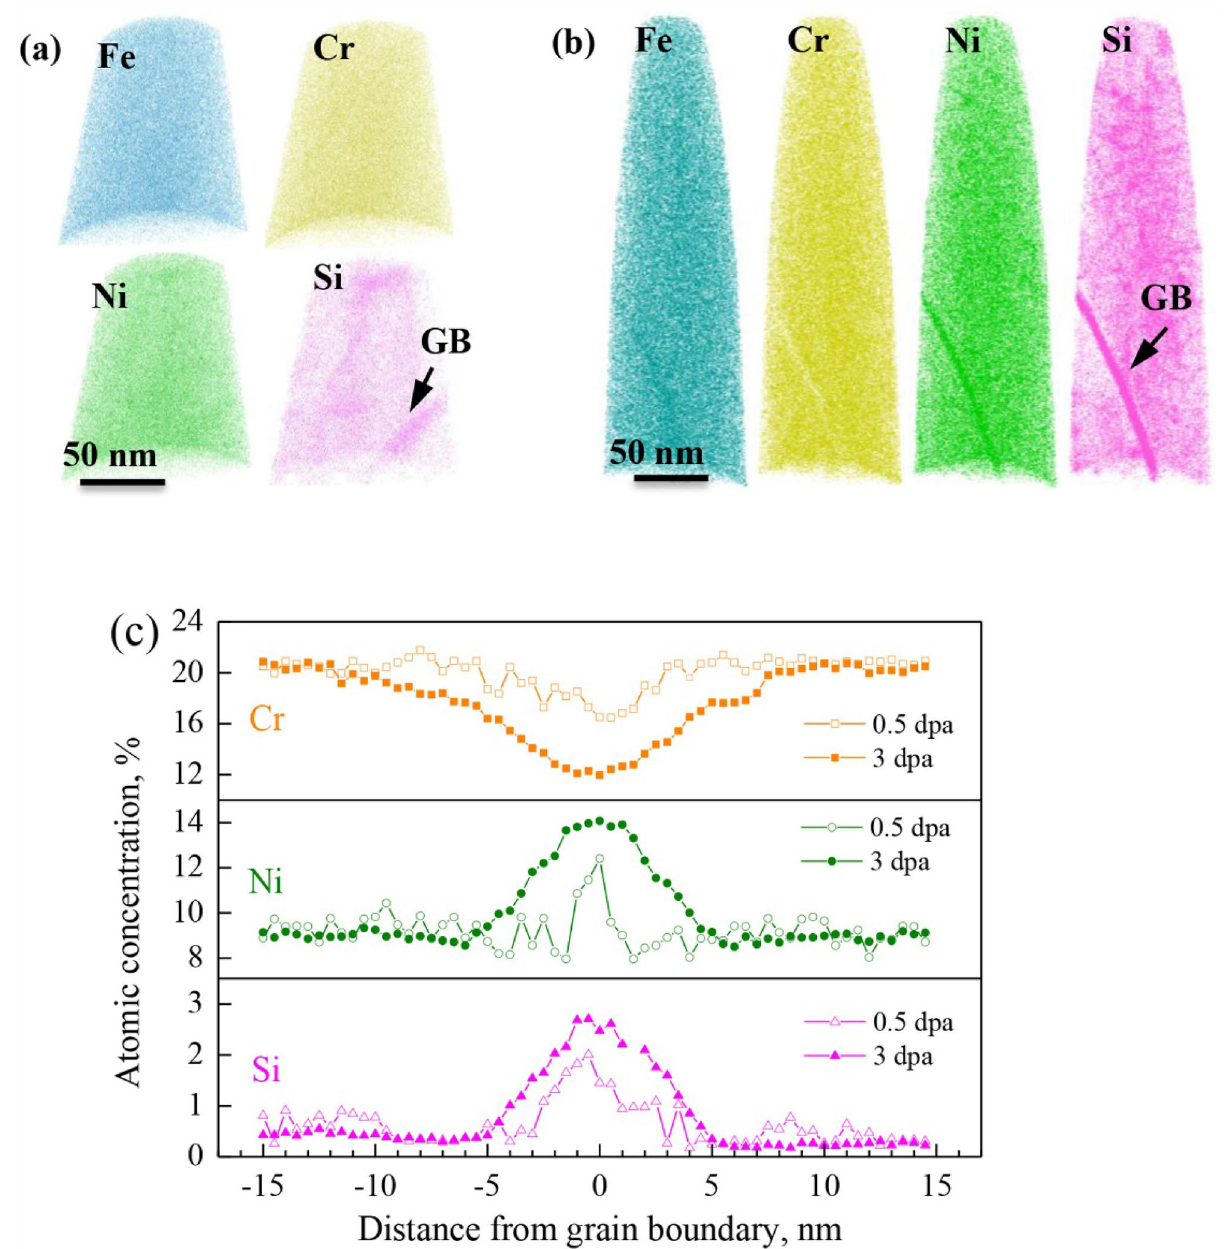
depletion of Cr and Mn and enrichment of Fe, Ni and Si at grain boundary. The position of grain boundary is highlighted by the arrow. ( c ) 1D concentration profiles across the grain boundary in the analyzed volume. *Atom maps in ( a ) and ( b ) were reconstructed using the commercial CAMECA Imago Visualization and Analysis Software package (IVAS, Version 3.6.8). URL link: https:// www. cameca.